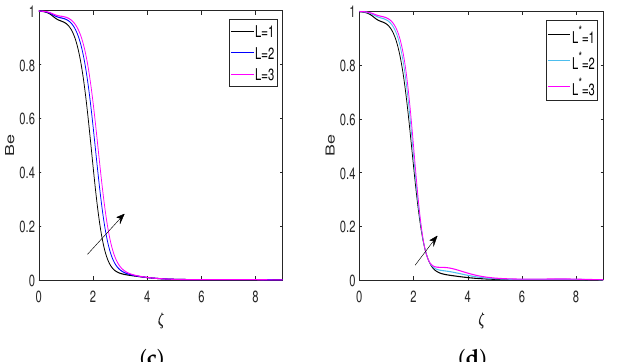
Figure 9. Bejan number profiles for different influential parameters. ( a ) Bejan number versus Pr ; ( b ) Bejan number versus Ec ; ( c ) Bejan number versus L ; and ( d ) Bejan number versus L ∗ . Contour plots illustrate the impact of different influential flow parameters on entropy generation parameter N s and Bejan number Be in the Figure 10a–l. Figure 10a shows the variation of β 1 and β 2 on the entropy N s . An increment in β 1 and β 2 reduces the entropy values. The behavior of β 1 and β 2 versus Be is displayed in Figure 10f. The Be rises with β 1 and β 2 , but the growth rate of the Bejan number due to β 1 is more compared with β 2 . The contour plot illustrating the effect of M and E 1 on entropy is shown in Figure 10b. An opposite effect on entropy is observed with M and E 1 , i.e., an increment in M declines the